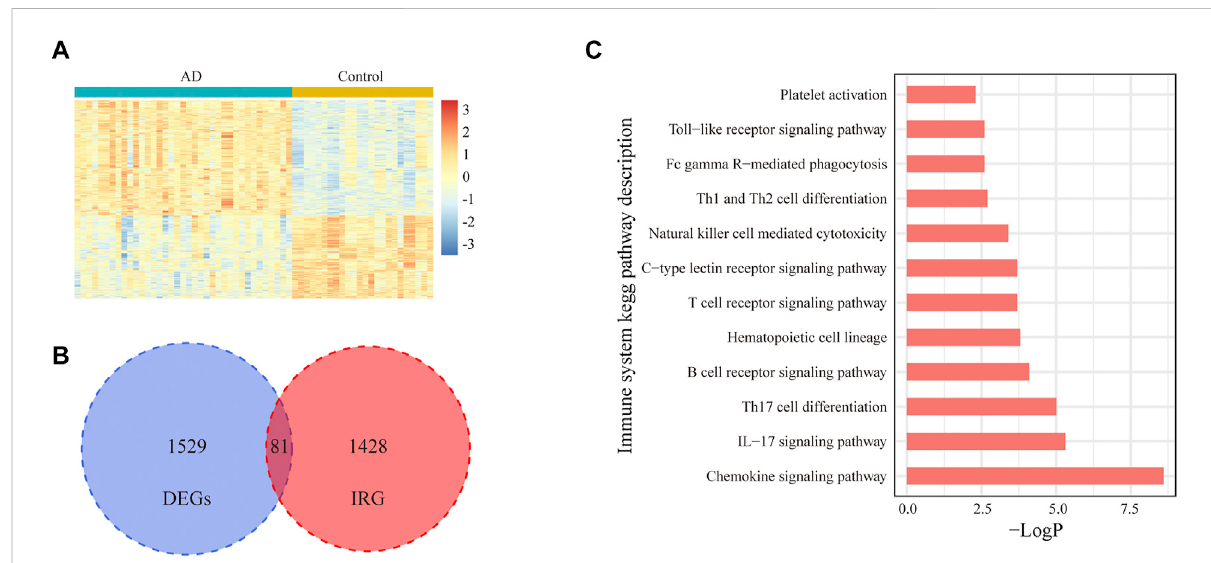
FIGURE 1 Expression of IRGs in the entorhinal cortex for AD and control samples in the GSE118553 dataset. (A) . Heatmap of 1,610 DEGs in the entorhinal cortexforADandcontrolsamplesintheGSE118553dataset.TheDEGswere fi lteredwith|log2foldchange(FC)| > 0.5andadjusted p value < 0.05. (B) . In total, 81 IRGs in DEGs are displayed with a Venn diagram. (C) . In total, 12 immune system pathways were signi fi cantly enriched with 81